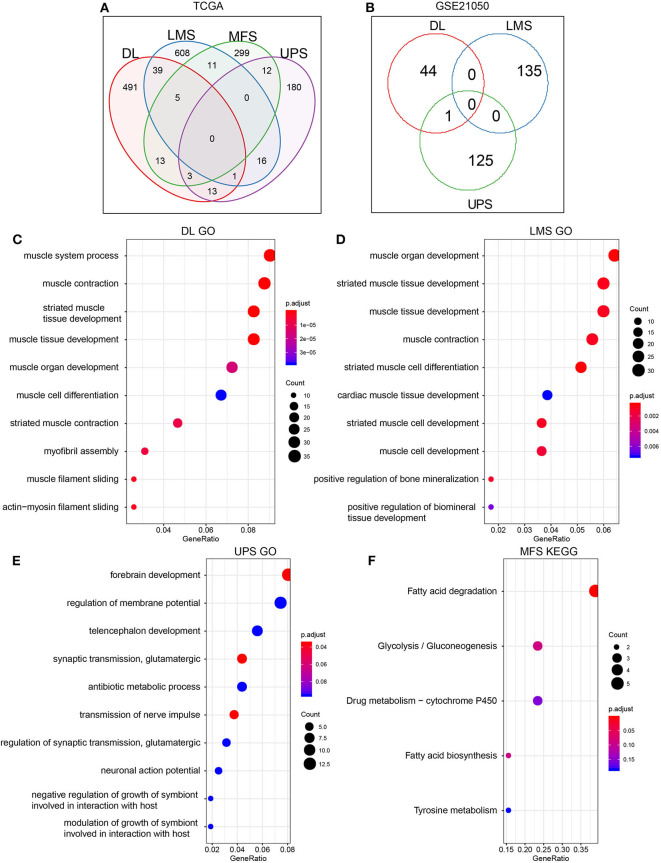
Screening of MRS in metastasis and non-metastasis sarcoma pathological subtypes. (A) TCGA. (B) GSE21050. Enrichment results of MRS GO Biology Process in THE TCGA dataset of sarcoma pathological subtypes: (C) DL. (D) LMS. (E) UPS. (F) The enrichment results of MFS MRS KEGG Pathway (MRS of MFS did not show significant enrichment term on GO, but significant enrichment results were shown on KEGG pathway, so KEGG pathway enrichment results are shown here).